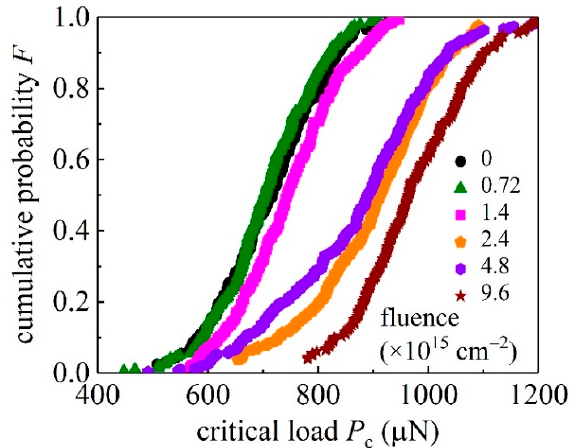
Figure 3. Cumulative pop-in probability as functions of the critical load P c at different values of ion fluence D .